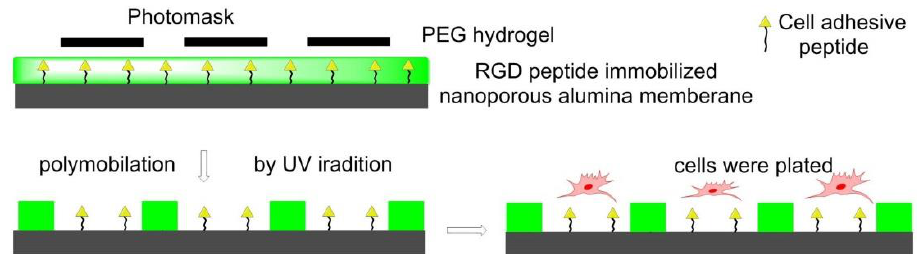
Figure 11. Photolithography strategy for surface functionalization. The photoinitiator-containing gel precursor solution was added on RGD peptides immobilized nanoporous alumina membrane to form a thin layer. Then it was covered by photomask and irradiated by UV light to get polymerization. Fibroblasts cells were seeded in the nanowells.